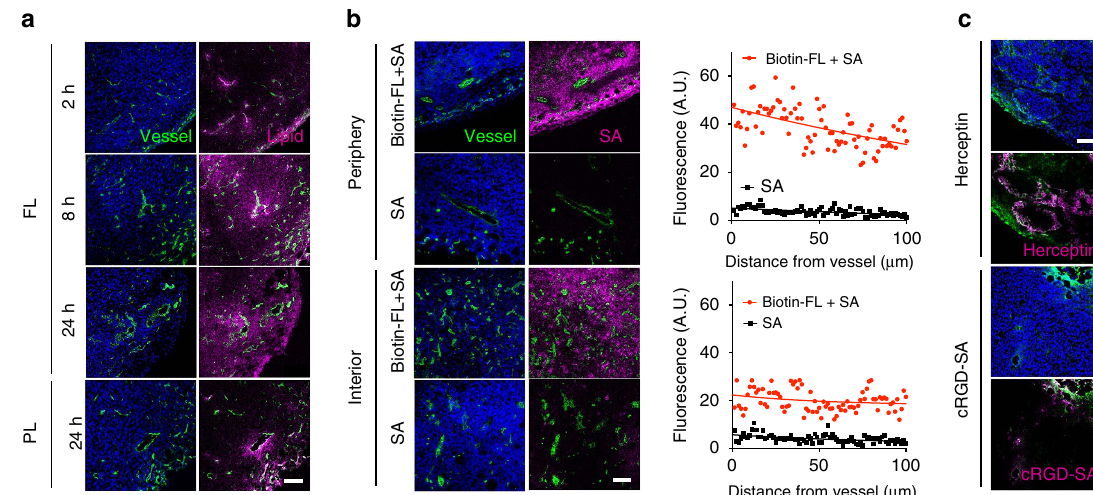
Figure 5 | Cooperative tumour cell membrane-targeted delivery. ( a ) Fluorescence images of 4T1 tumour sections after intravenous injection of FL or PL incorporating fluorophore-lipids (magenta). ( b ) Fluorescence images of 4T1 tumour sections and accumulation profiles of fluorophore-streptavidin (SA) after two-step targeted delivery. Mice bearing 4T1 tumours were intravenously injected with biotin-FLs or phosphate-buffered saline 1day before the intravenous injection of fluorophore-SA (magenta). Tumours were collected 2 days after fluorophore-SA injection. ( c ) Fluorescence images of NCI- N87(Her2 þ ) and MDA-MB-231( a v b 3 integrin þ ) tumour sections 48h after intravenous injection of Herceptin (magenta) and cRGD-SA conjugated with fluorophores (magenta), respectively. Nuclei were stained with Hoechst (blue) and vessels with CD31 (green). Scale bar represents 100 m